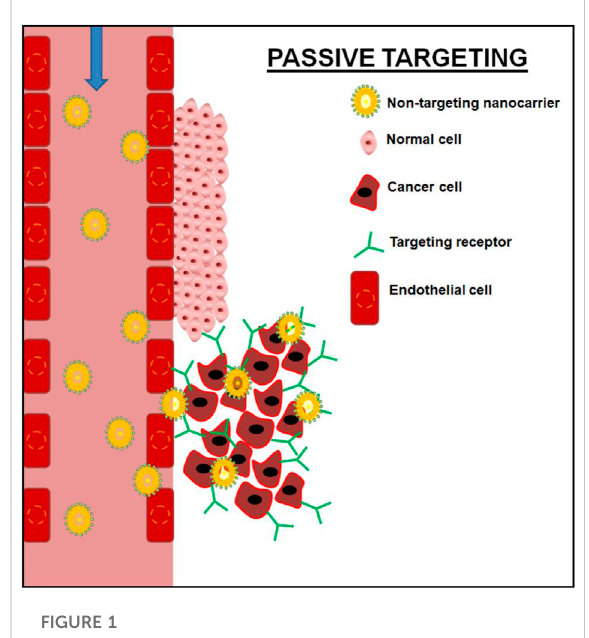
FIGURE 2 Schematic illustration of active targeting of cancer cell using targeting